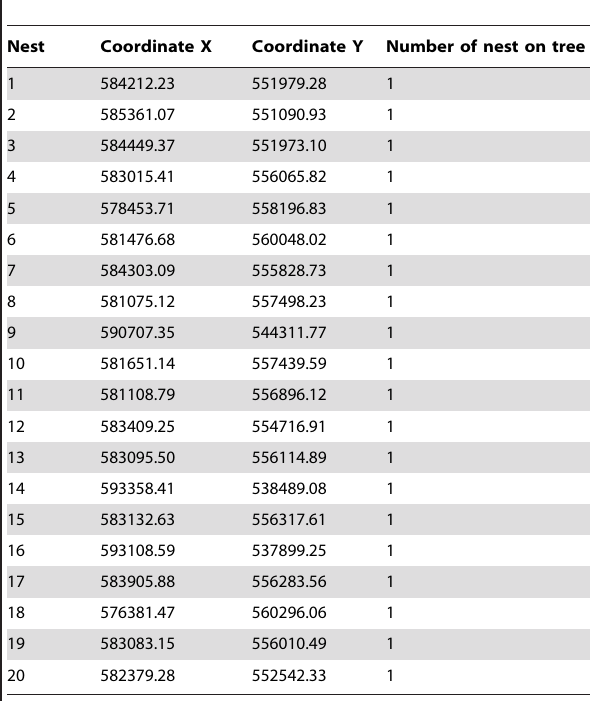
Table 5. The distribution data of low solitary nests of Apis dorsata in Marang district.